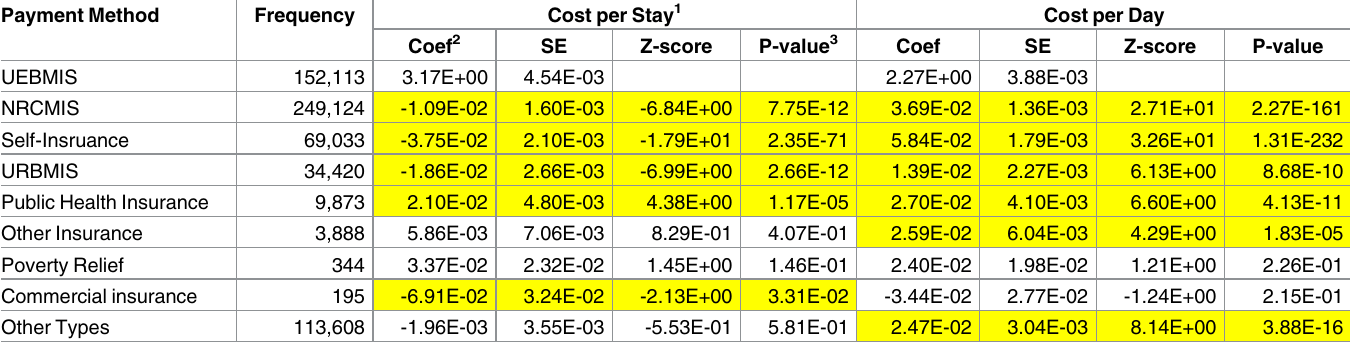
Table 3. Estimated cost per stay and cost per day across different payment methods, where insurance for urban worker is treated as the